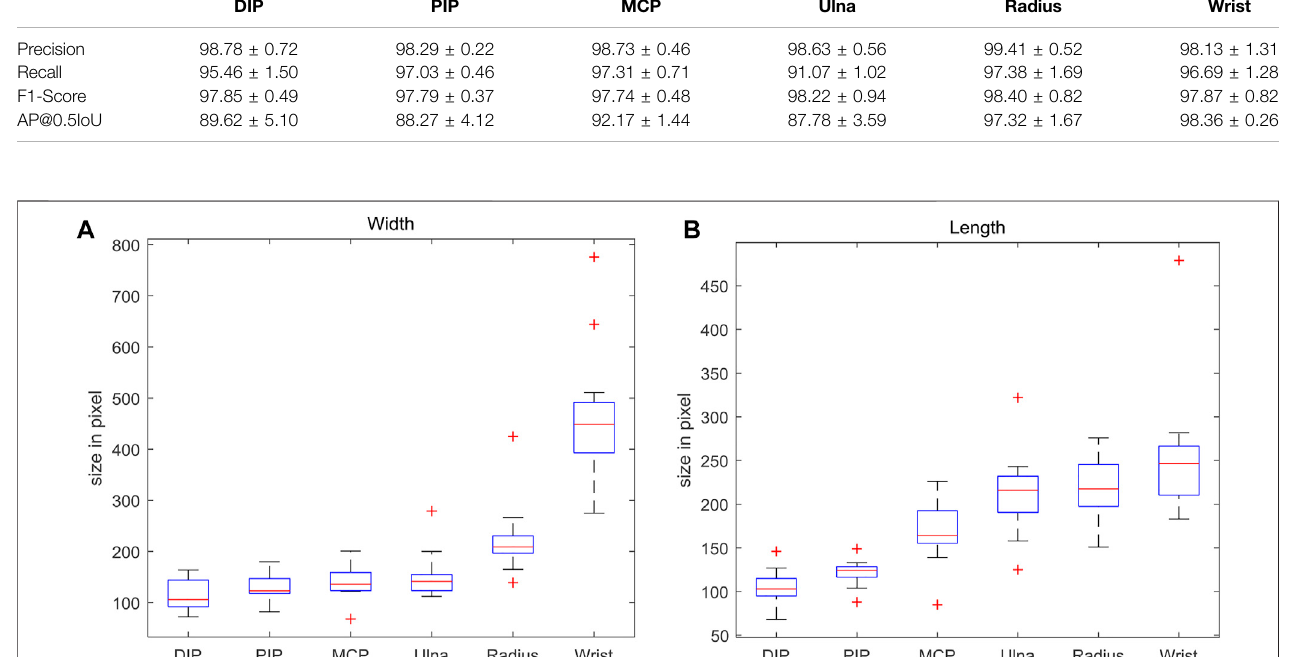
FIGURE 6 | The bounding box sizes of extracted ROIs in testing dataset. (A) Width; (B) length.